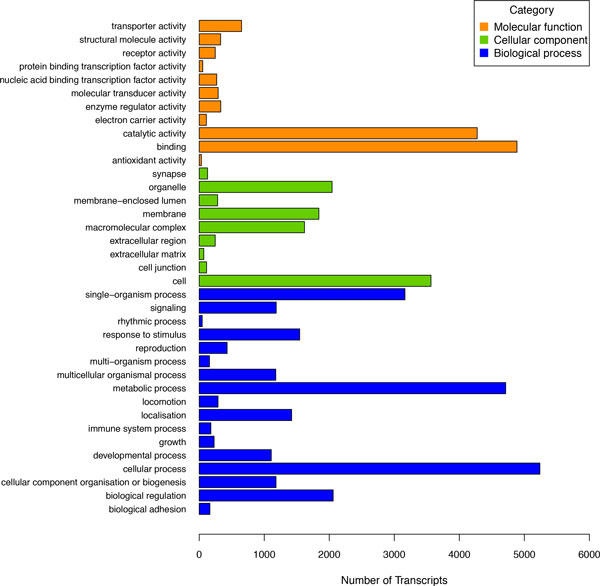
Classification of the gene ontology (GO) terms for the B. jarvisi transcriptome. GO was implemented in BLAST2GO on a subset of the CLC assembly comprising 23,518 contigs. Of these, 8,864 transcripts (45.6%) were classified into 37 functional groups.